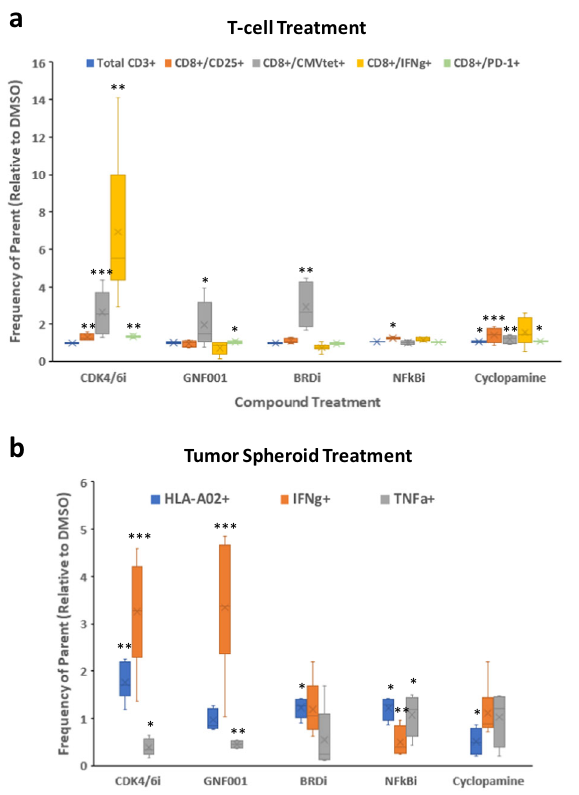
Fig. 7 Compound treatment of individual T-cell or spheroid cellular populations reveals the compound mechanism of action. a T-cells were treated with hit compounds or DMSO vehicle control for 48 h and phenotypically pro fi led by FACS. b Tumor spheroid cultures were treated with hit compounds or DMSO vehicle control for 48 h and phenotypically pro fi led by FACS. An independent sample t -test was used to calculate probability where * p < 0.05, ** p < 0.01, *** p < 0.001; n = 3 independent experiments and error bars indicate standard